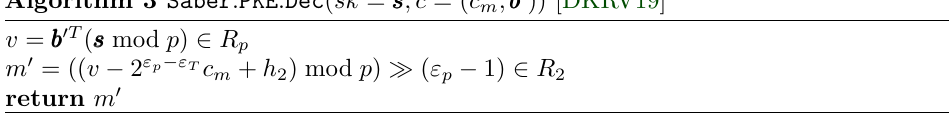
Algorithm 3 Saber . PKE . Dec ( sk = sss, c = ( c m ,b 0 b 0 b 0 )) [DKRV19]